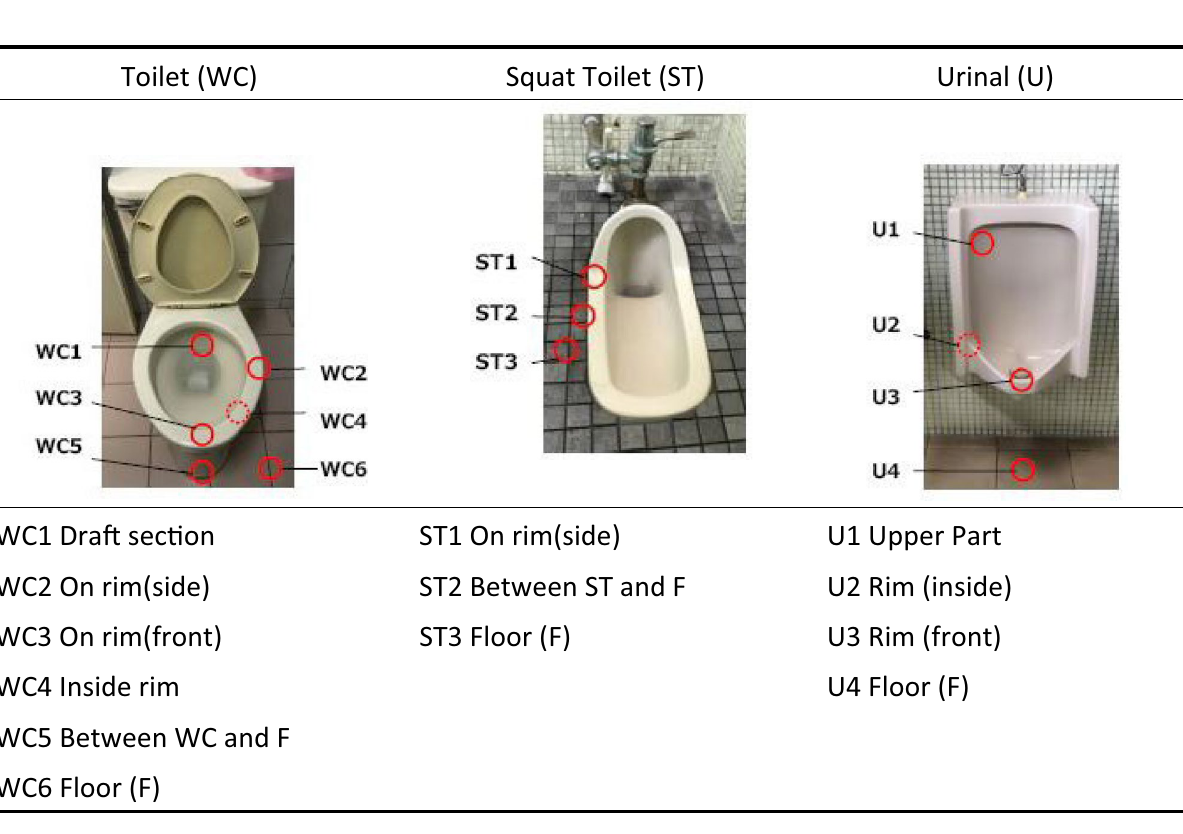
Table 1. The sampling point of bacteria on the